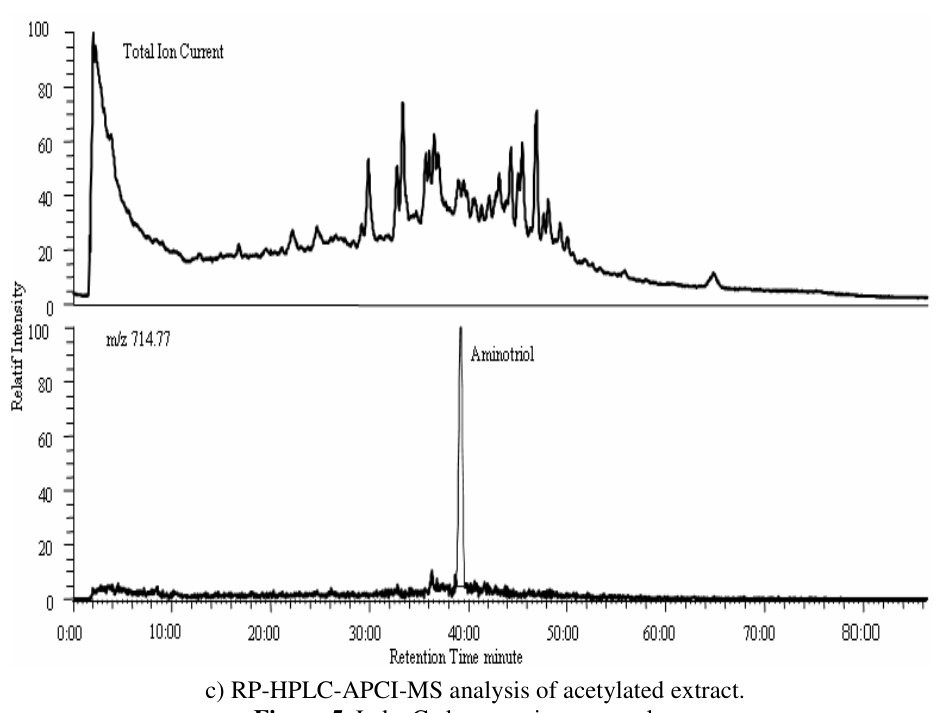
Figure 5. Lake Cadagno-oxic zone analyses